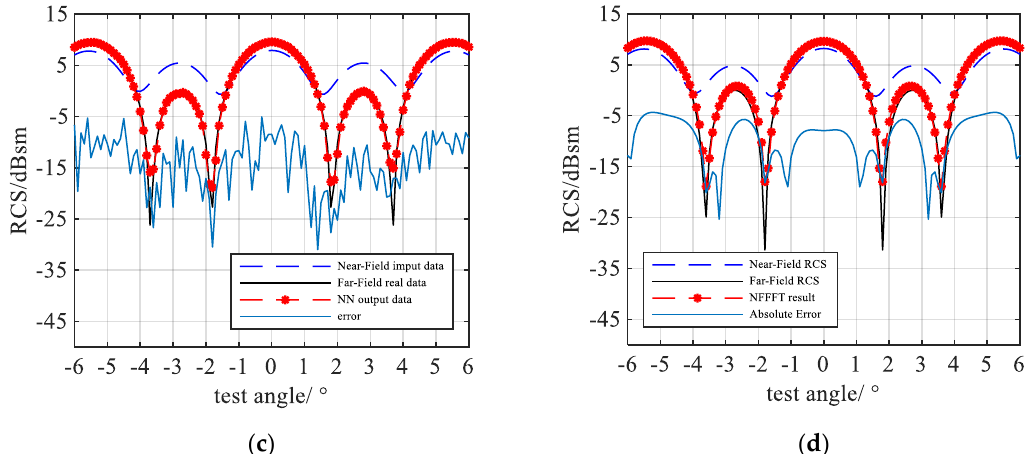
Figure 7. Simulation result for different test samples: ( a ) 5-point target R = 5.47λ NN-NFFFT result ( b ) 4-point target R = 6.8λ NN-NFFFT result ( c ) 3-point target R = 5.2λ NN-NFFFT result ( d ) 3-point target R = 5.2λ “image-based” NFFFT result with 401 frequency points.